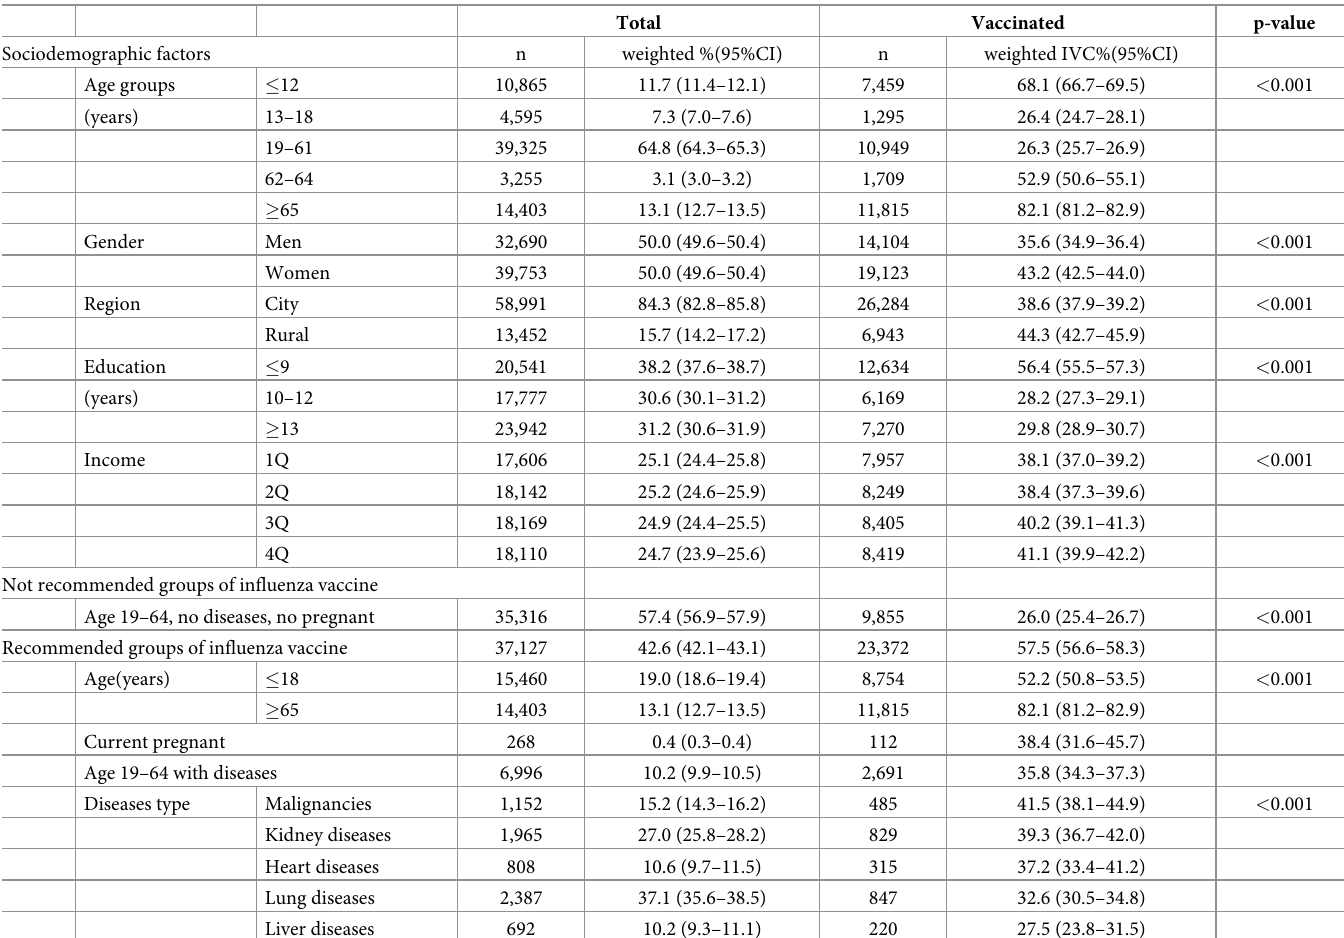
Table 2. General Characteristics and Influenza vaccination coverages (n =